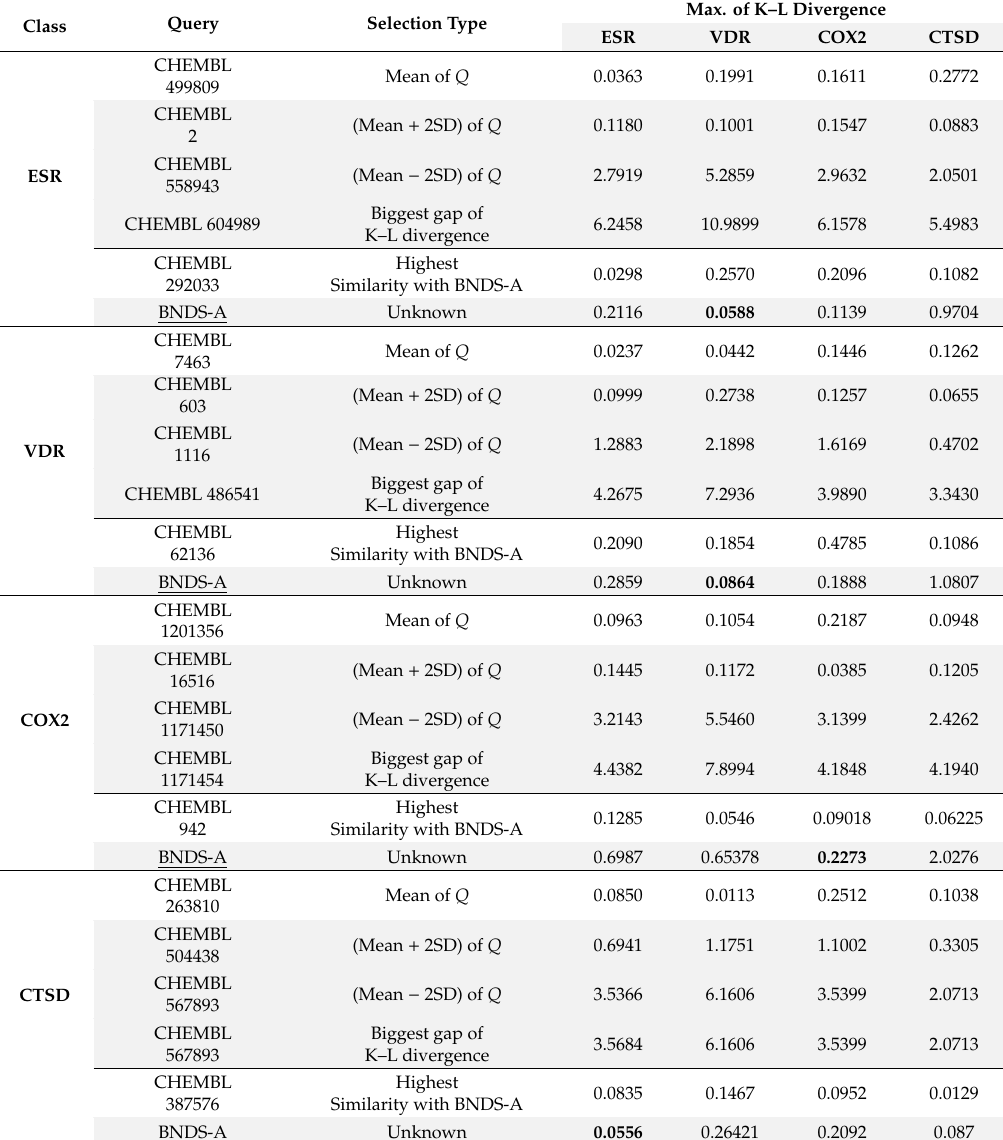
Table 5. The comparison between representative queries and unprecedented drug BNDS-A as a